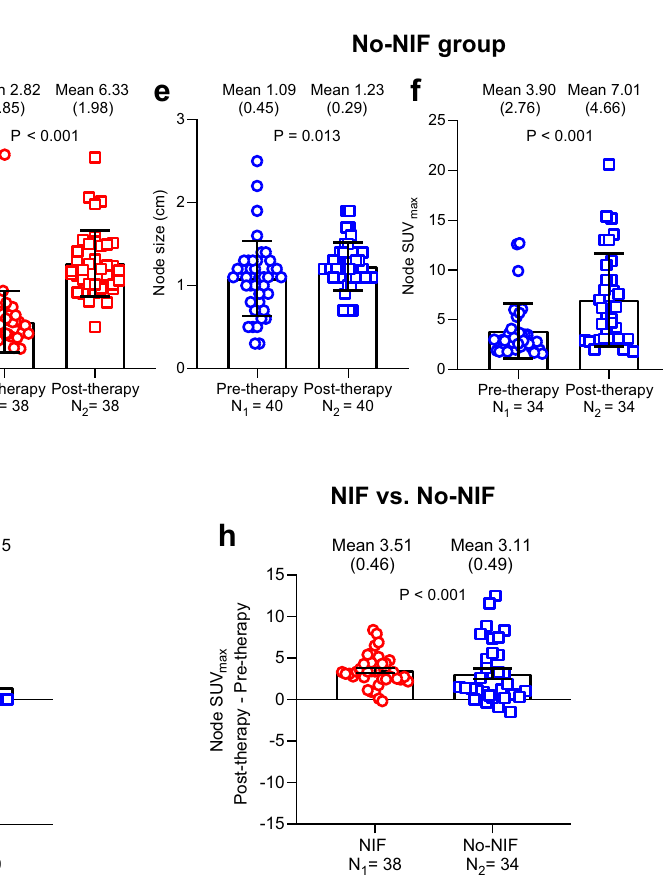
( P = 0.001) in nodes from patients with NIF. In contrast, genes involved in immunosuppressive pathways, including the trans- forming growth factor β (TGF β ) and the SMAD2/3 nuclear signaling pathways were downregulated ( P < 0.005) in nodes from NIF patients (Fig. 4h; Source Data fi le). Together, these results suggest that the microenvironment of nodes of patients with NIF/ non-caseating granulomas is in fl amed and enriched in macro- phages, dendritic and Th1 cells that may be involved in functional pathways of immune response and reduced immune suppression. Association of NIF with pathological and radiological tumor responses and ICI-related toxicity . Since the primary endpoint of NEOSTAR trial was the rate of MPR in resected tumors in